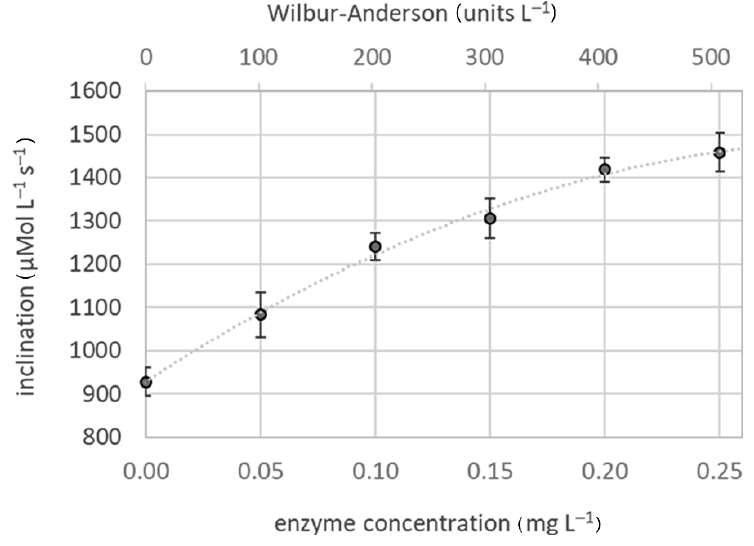
Figure 4. Calibration curve using bovine CA: enzyme concentration/units versus inclination of the HCO 3 − graph. Wilbur-Anderson units were calculated from the measured activity of the standard enzyme.